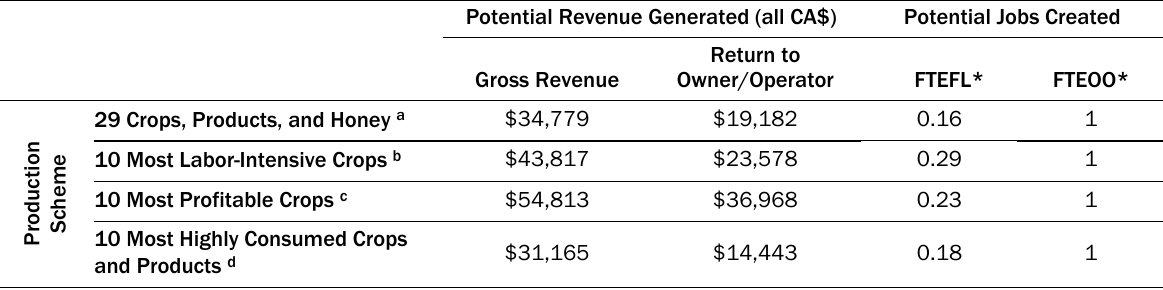
Table 3. Economic and Job Creation Potential of 0.4 ha (1 acre) of Underutilized ALR Land in Surrey, B.C., Under Four Production